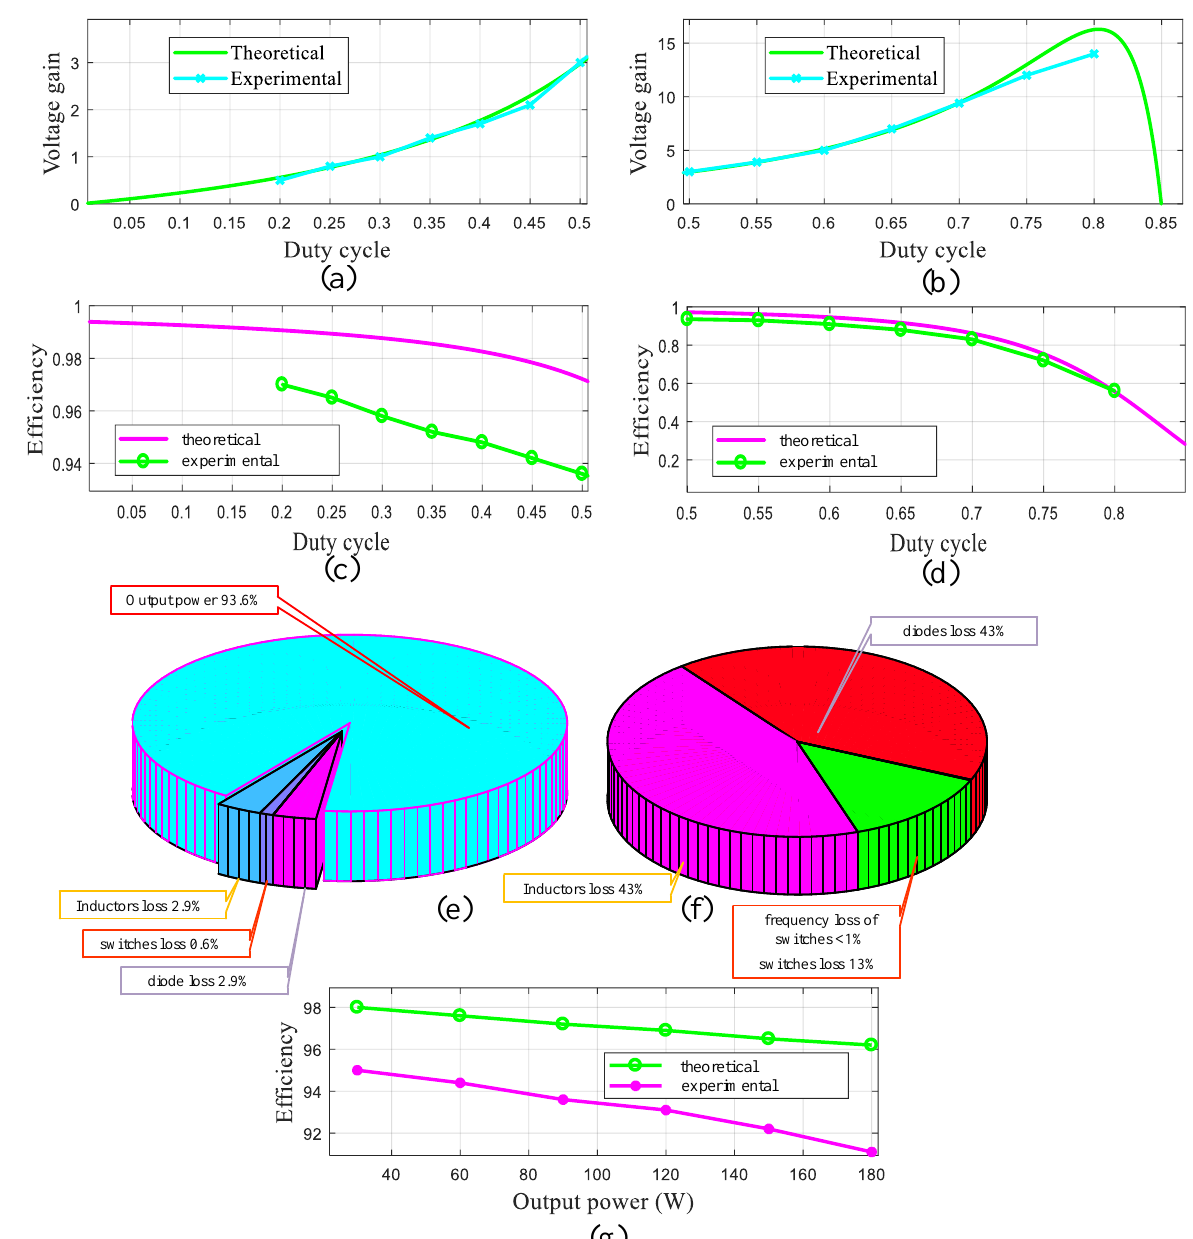
Figure 9. Theoretical analysis vs. experiments: ( a ) the comparison of the theoretical and experimental voltage gain, while the duty cycle varies from 0 to 50 percent; ( b ) the comparison of the theoretical and experimental voltage gain, while the duty cycle varies from 50 to 100 percent; ( c ) the comparison of the theoretical and experimental efficiency, while the duty cycle varies from 0 to 50 percent; ( d ) the comparison of the theoretical and experimental efficiency, while the duty cycle varies from 50 to 100 percent; ( e ) pie chart of the efficiency and losses; ( f ) loss break down; ( g ) comparison of the theoretical and experimental efficiency for varying output power, from 30 to 180